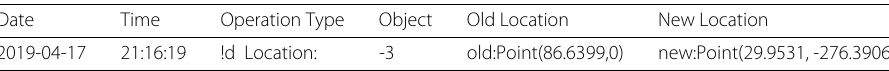
Table 2 An example of log data on BJUTModeling